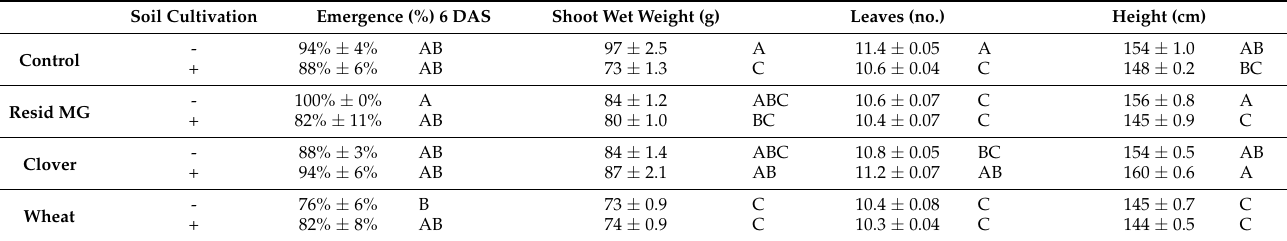
Table 4. The field experiment—growth parameters at 50 DAS 1